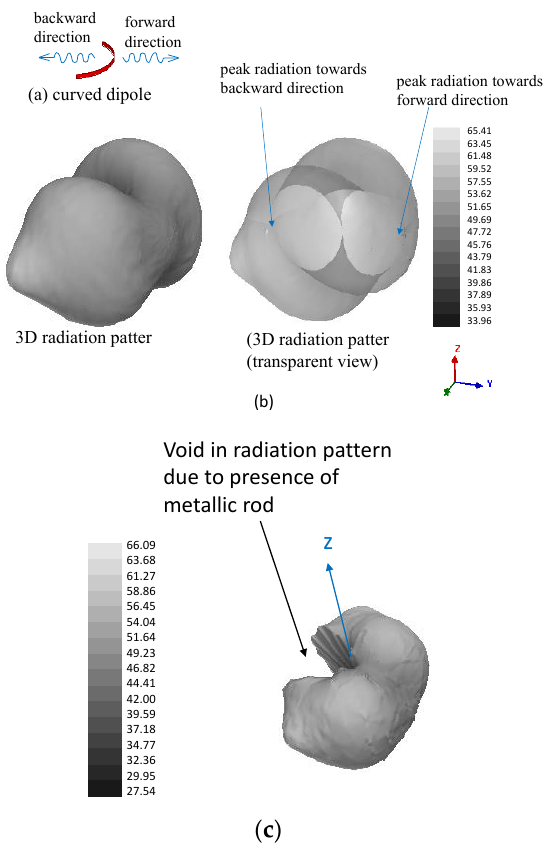
Figure 4. ( a ) Curved dipoles showing the forward and backward propagation direction, ( b ) E-field radiation pattern without the metallic rod, ( c ) E-field radiation pattern after the metallic rod is inserted.